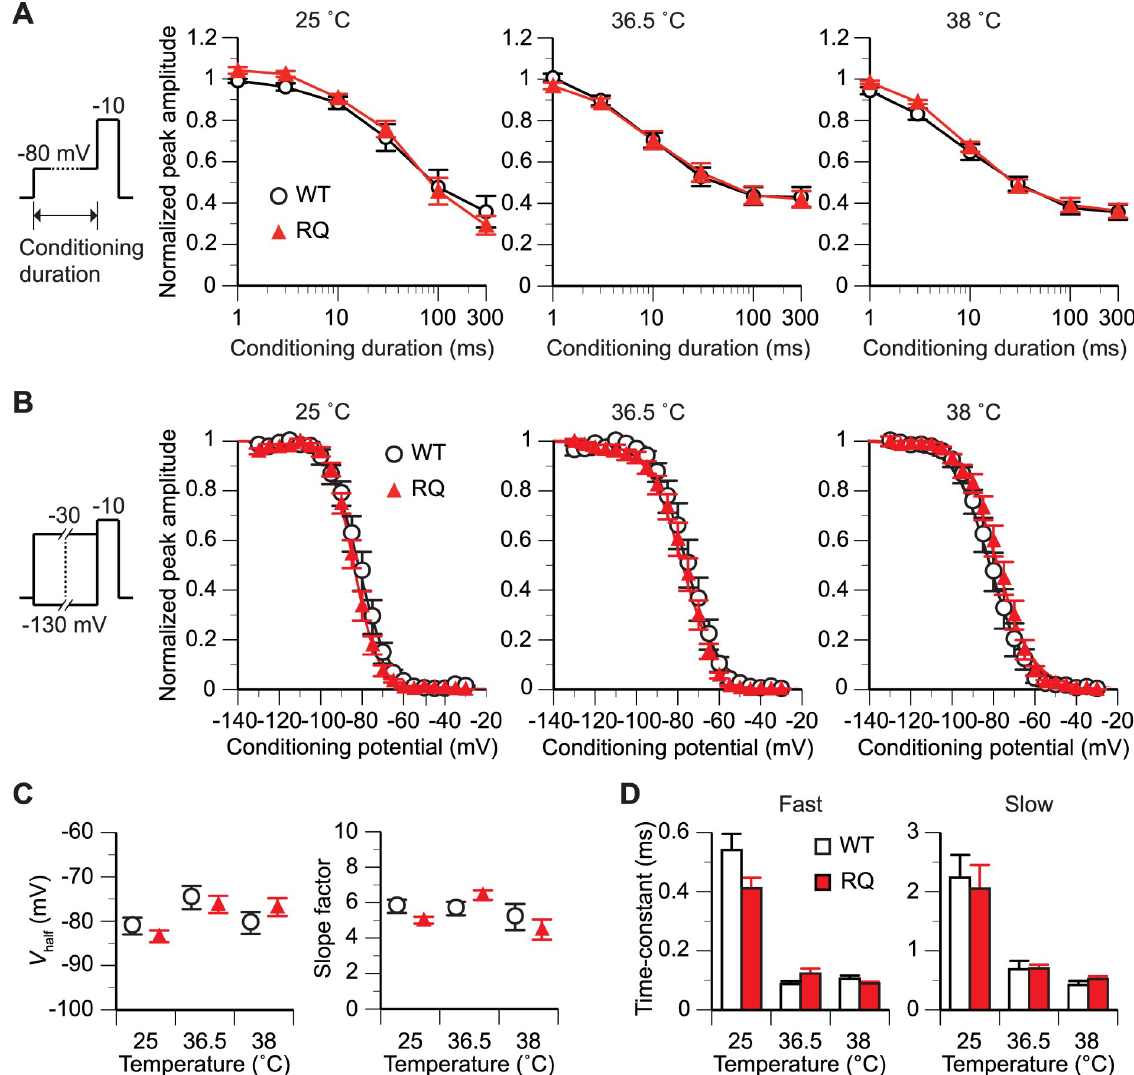
Fig 3. SCN5A(R1193Q) did not affect the inactivation gating at any tested temperature. (A) The time dependence of inactivation was measured with a double-step voltage protocol (schematic in panel A; holding potential, -120 mV). The duration of the conditioning step varied from 0 to 300 ms. The duration of the test step was 20 ms. The graph plots the peak amplitude of I Na evoked at the test step against the duration. The amplitude is expressed relative to that with a conditioning duration of 0 ms. p > 0.05 between WT and RQ cells [repeated measures analysis of variance (rmANOVA)]. n, 5 WT and 5 RQ cells for each data point. (B and C) The voltage dependence of inactivation was measured with a double-step voltage protocol (schematic in panel B; holding potential, -120 mV). The conditioning step was fixed at 500 ms in duration and varied from –130 to –30 mV in voltage. The duration of the test step was 20 ms. (B) The graph plots the relative peak amplitude of I Na evoked at the test step against the conditioning voltage. n, 8–10 WT and 8–13 RQ cells for each condition. The Boltzmann sigmoidal function was fitted to the data from all tested cells for each condition. (C) Comparison of the mean V half and slope factor estimated from the Boltzmann function fitted to the g-V plot for each cell. p > 0.05 between WT and RQ cells for all temperatures (unpaired t -test). (D) Comparison of mean time constants of the fast and slow components of I Na decay. The values were estimated from the double-exponential function fitted to the decaying phase of I Na evoked at a test potential of –20 mV for each cell (Fig 1A). p > 0.05 between WT and RQ cells for all temperatures (unpaired t -test). n, 5–11 WT and 7–8 RQ cells for each